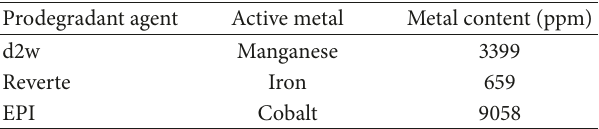
Table2:Activemetalsandcontentofprodegradantagentsinmaster batch.